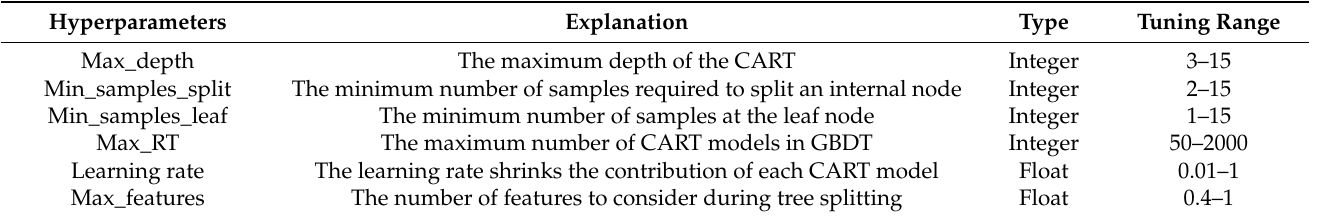
Table 4. Hyperparameters description and their tuning